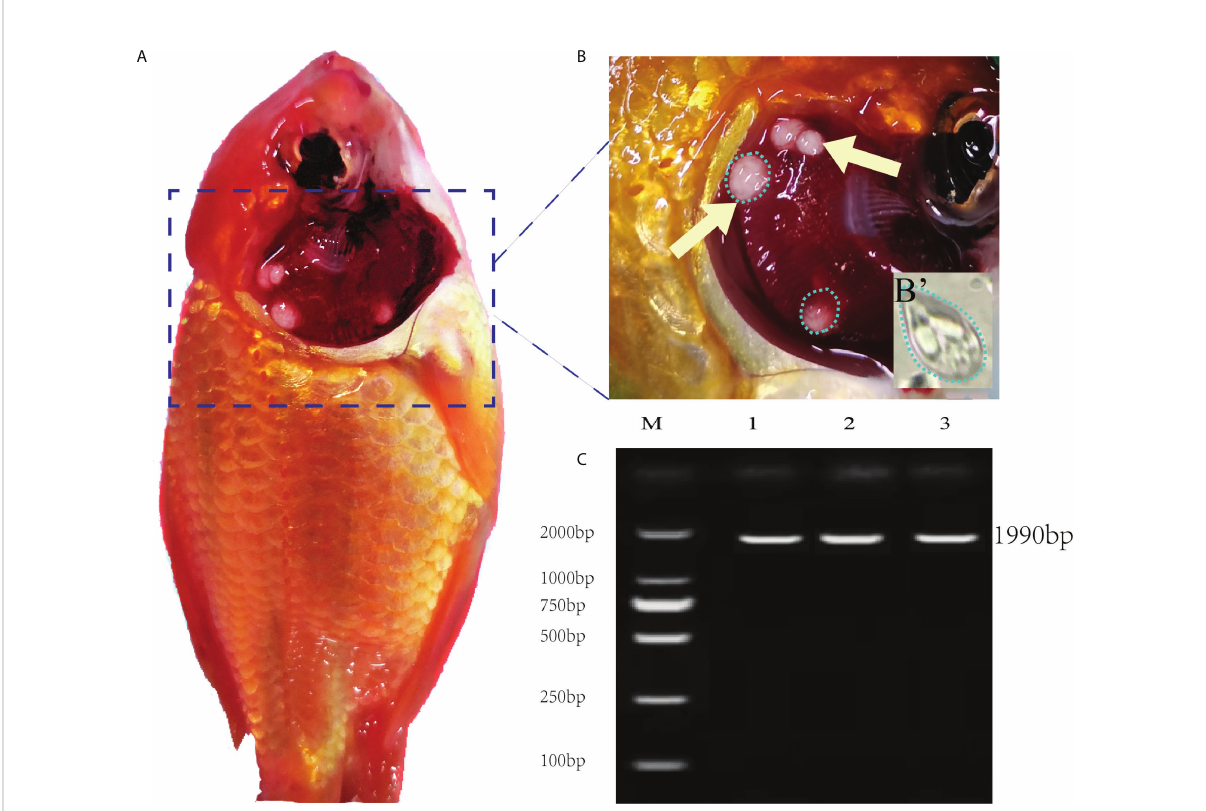
FIGURE 1 Clinical signs of diseased fi sh and electrophoretic results. (A) Clinical signs of gold fi sh infected with Myxobolus ampullicapsulatus . (B) Opalescent rounded cysts (dotted circle) of varying sizes appeared on the gills (arrows). (B ’ ) Spore morphology under high ampli fi cation fi eld with oil immersion lens, x100. (C) Electropherogram of Myxobolus ampullicapsulatus , M: marker. Lane 1-3: DNA of gold fi sh gill infected by Myxobolus ampullicapsulatus